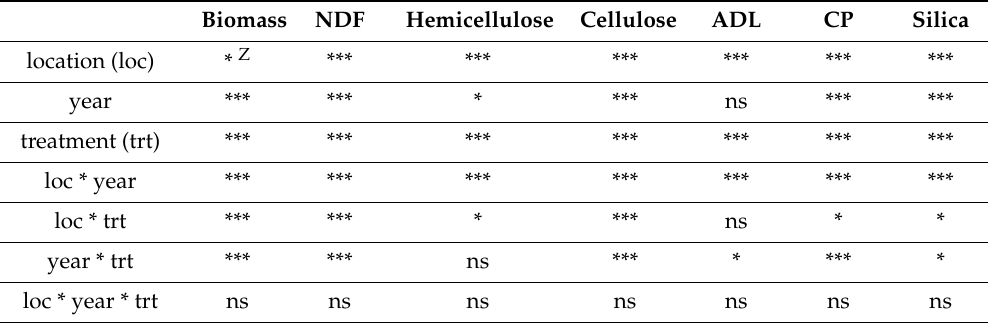
Table 2. Analysis of variance of biomass yield, hemicellulose, cellulose, acid detergent lignin (ADL), neutral detergent fiber (NDF), crude protein (CP), and silica concentration. Biomass NDF Hemicellulose Cellulose ADL CP Silica location (loc)